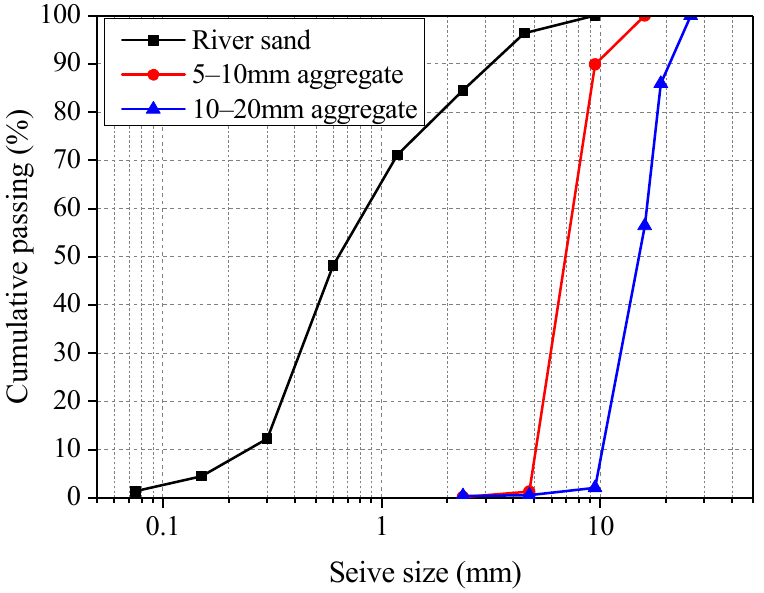
Figure 2. Particle size distribution curve of river sand and coarse aggregate.